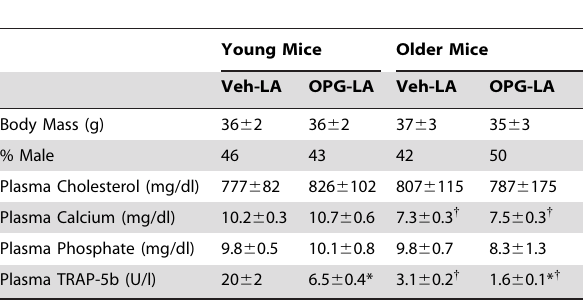
Table 1. Morphometric and metabolic